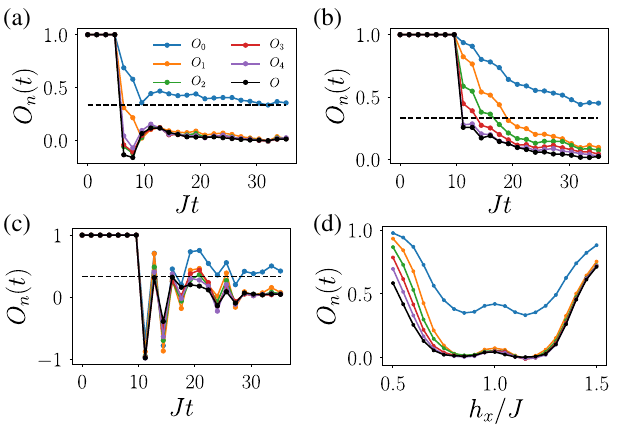
FIG. 4. O n ð t Þ vs O ð t Þ for chaotic dynamics in the kicked Ising model. All plots represent for N ¼ 8 sites the modified OTOCs O t Þ , for n ¼ 0 , 1, 2, 3, 4 and the OTOC O ð t Þ . The dashed line n ð shows the predicted value 1 = 3 for O 0 ð t Þ for Haar scrambling. (a) For h x ¼ 0 . 75 J , and j ¼ 3 , the OTOC decay is fast and well captured by the low-order OTOCs O n ð t Þ . (b) For a larger j ¼ 7 operator position, the OTOC decay is slower, as a consequence of the diffusive broadening of W ð t Þ . (c) For j ¼ 7 , and h x ¼ J , the decay of O ð t Þ is fast but accompanied by strong oscillations, which are also resolved by the modified OTOCs. (d) For a fixed long time Jt ¼ 35 . 2 , the modified OTOCs provide good approx- imations to O ð t Þ , in particular in the regime h x ≥ 0 . 75 J . Other parameters are h z ¼ 0 . 809 J , and JT ¼ 1 . 6